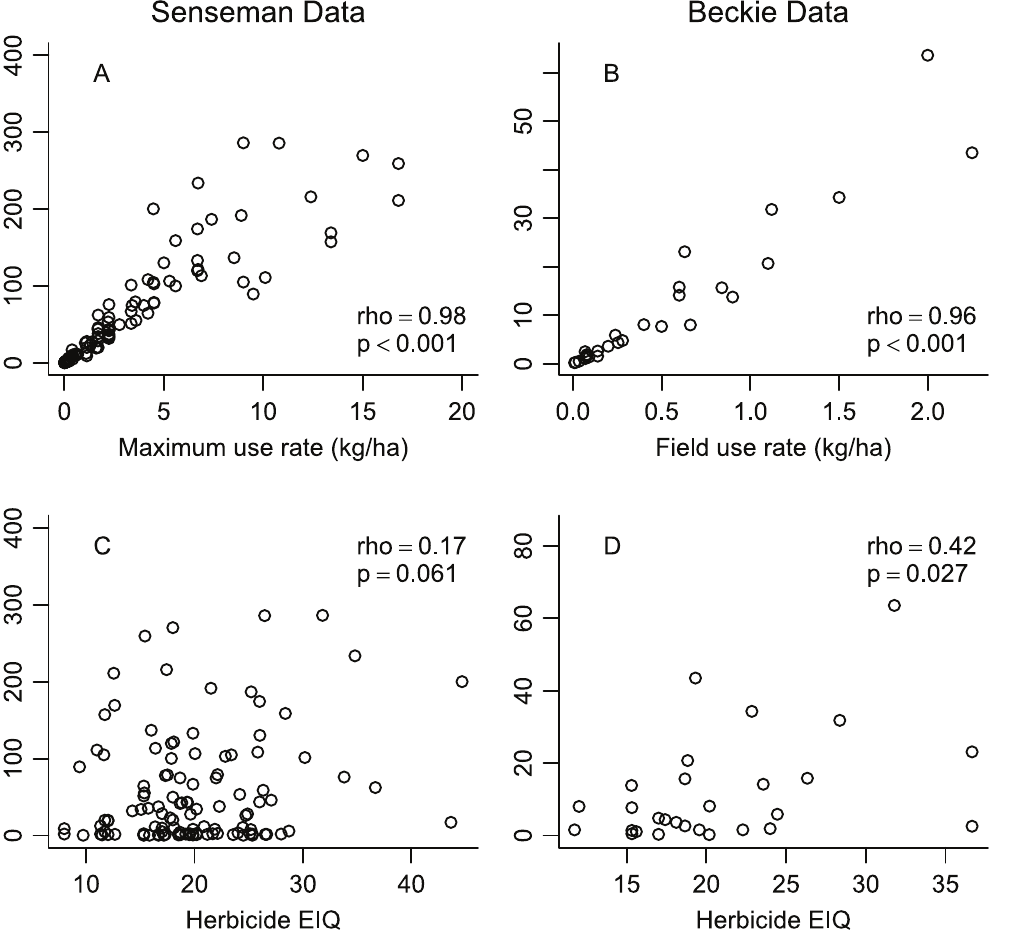
PLOS ONE | DOI:10.1371/journal.pone.0131200 June 29,